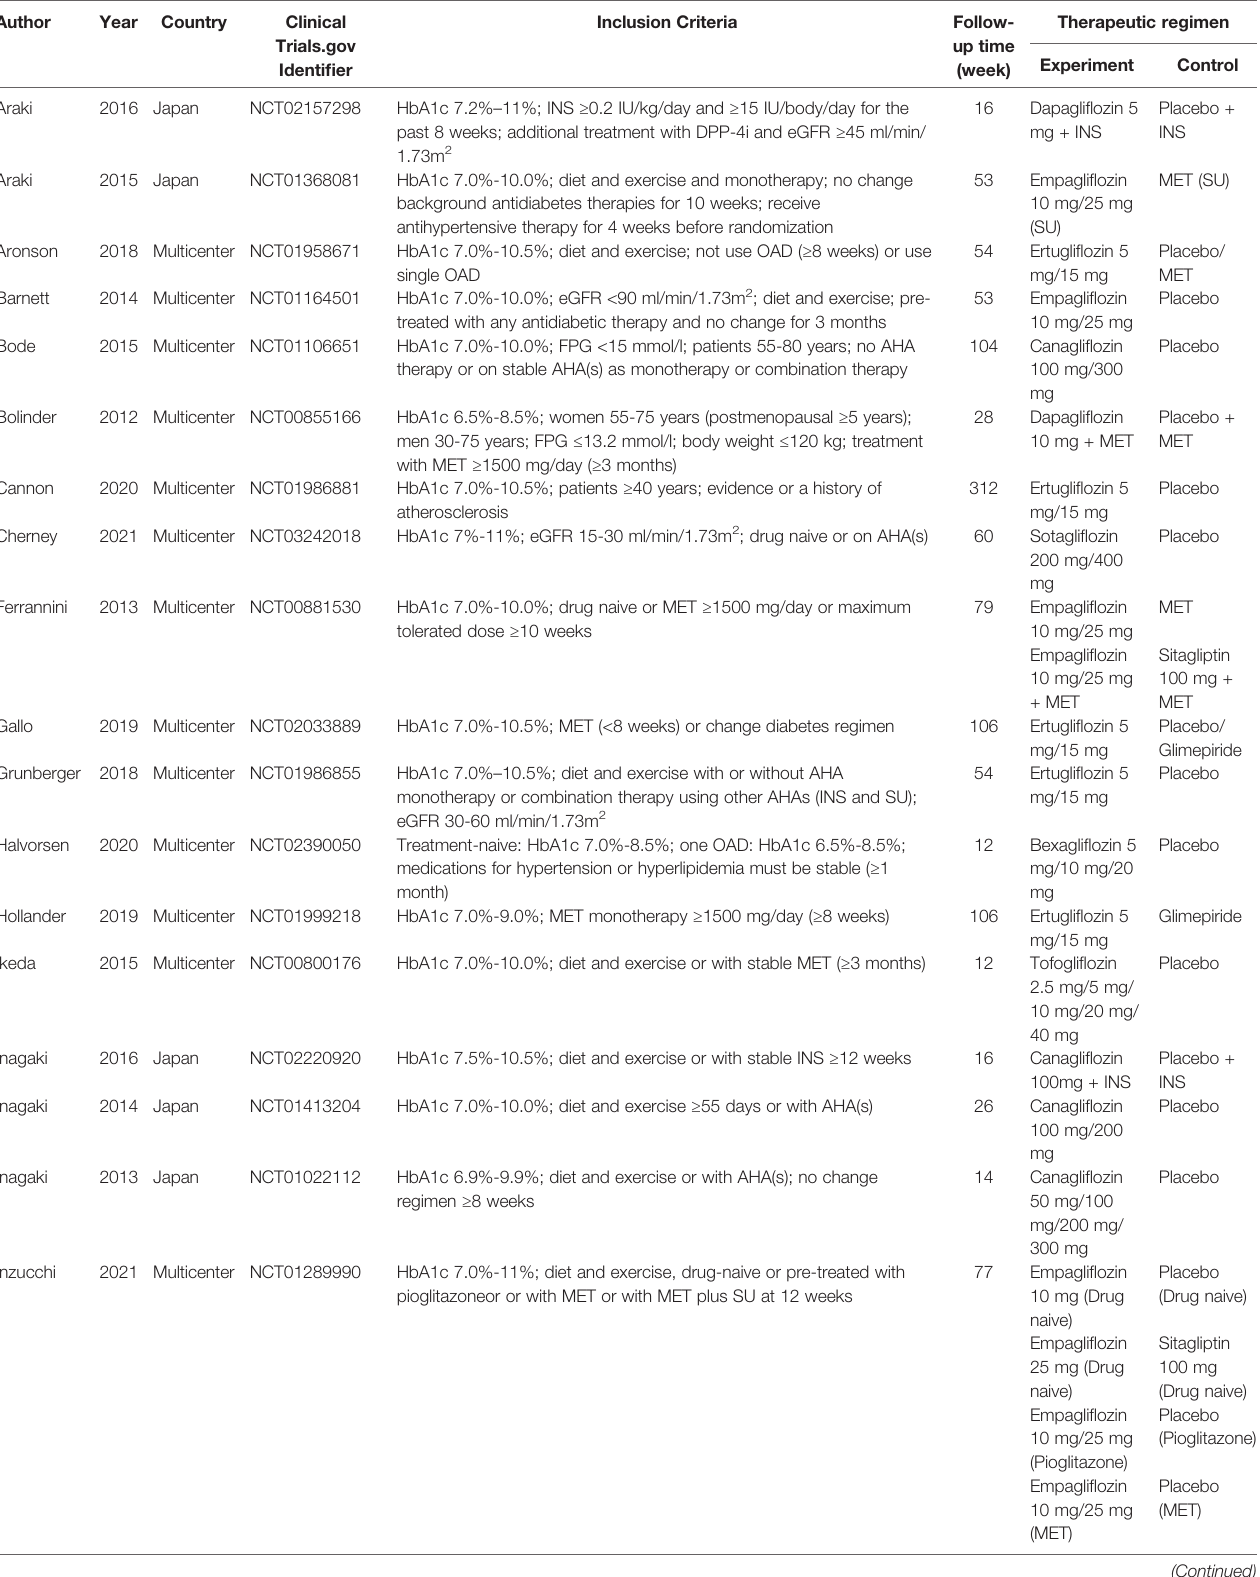
TABLE 1 | Characteristics of all studies included in the